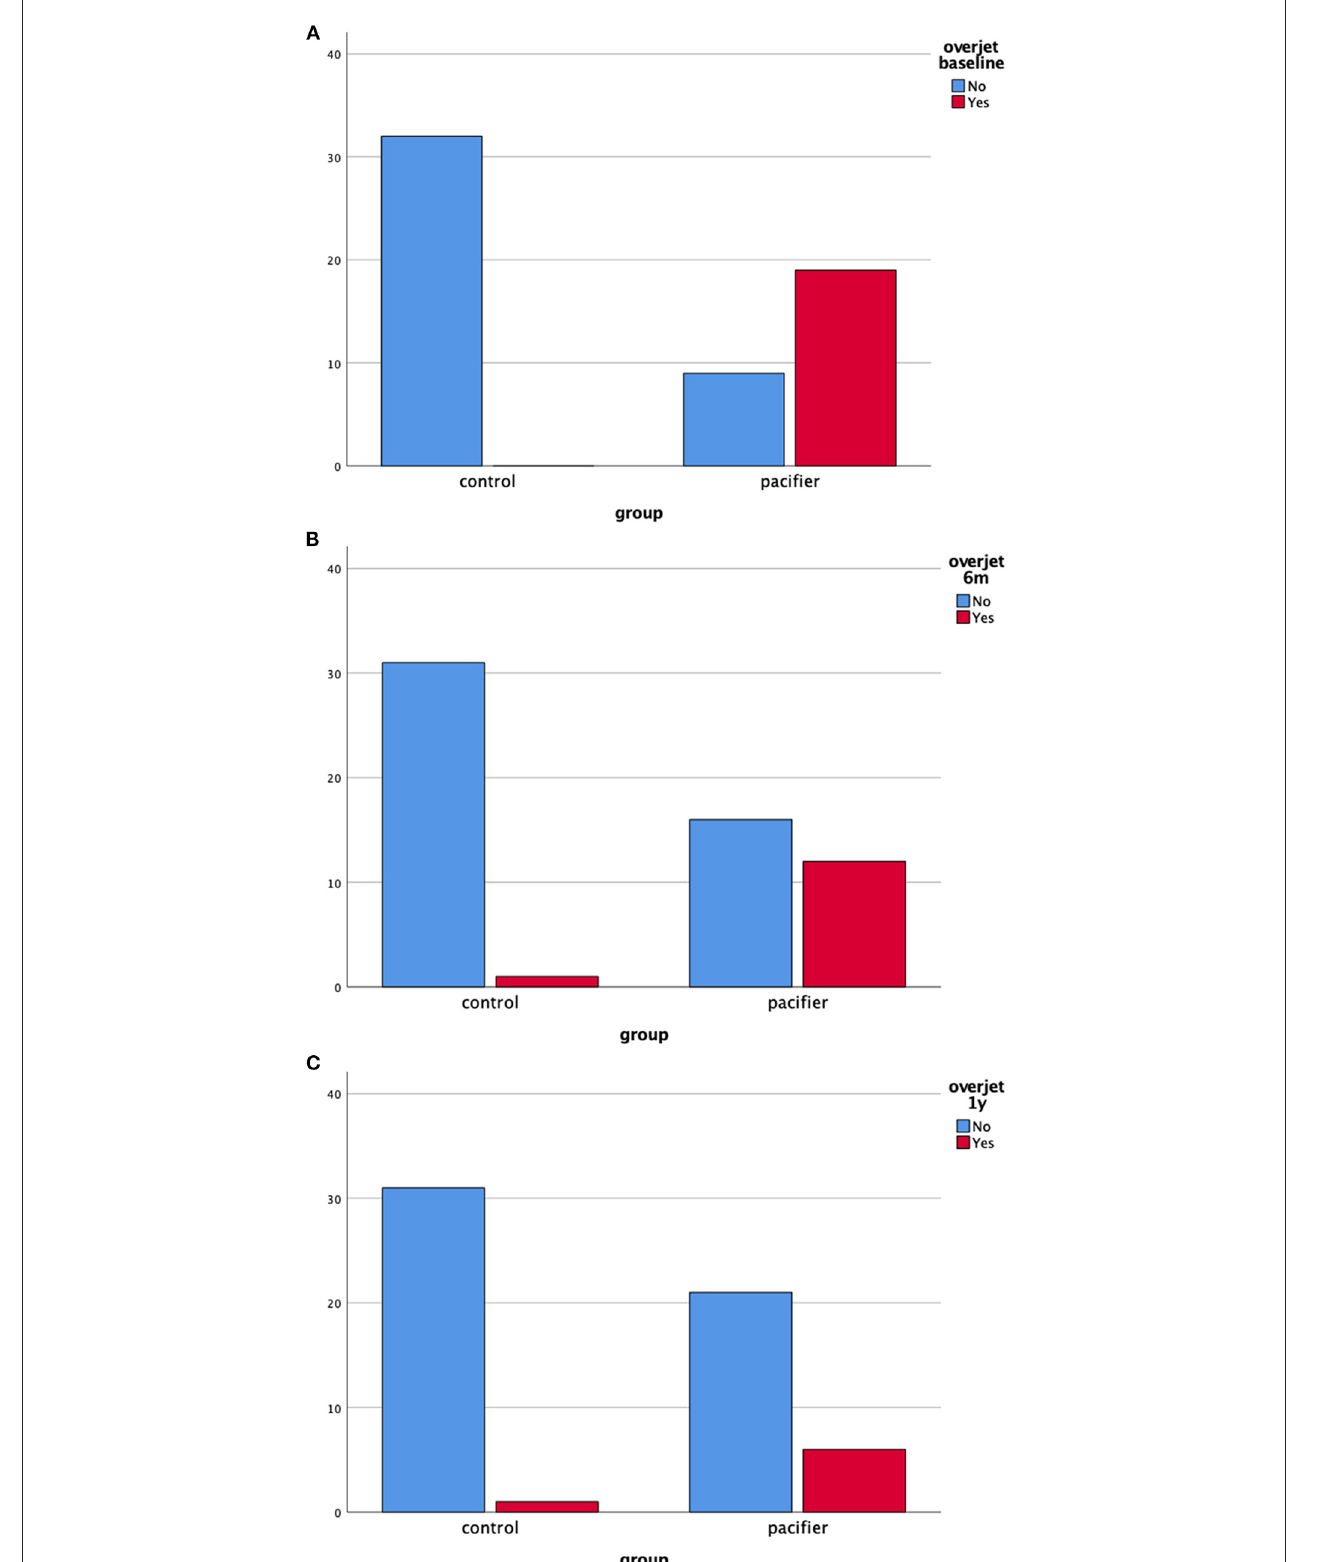
FIGURE 4 | (A–C) Absolute frequency of overjet in the clinical groups at baseline, 6 months and 1-year follow-up (total n = 60).